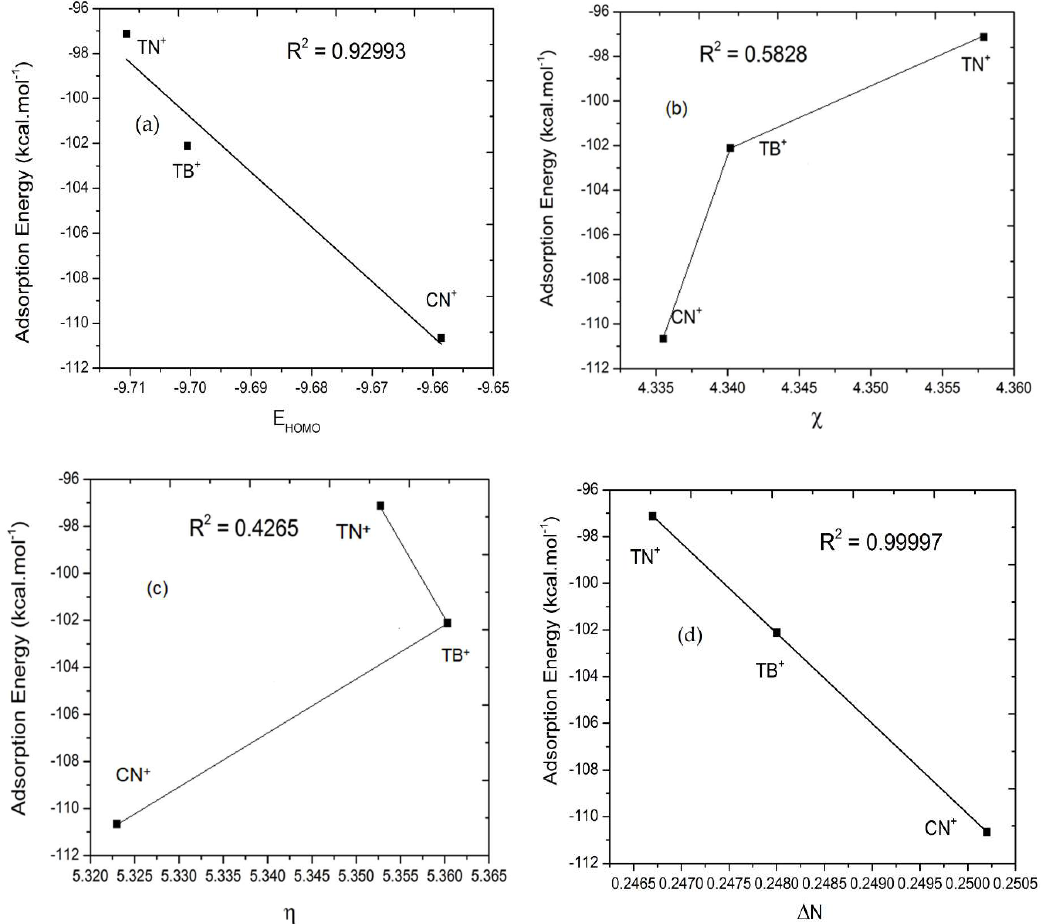
Figure 6. Correlation of the adsorption energy and quantum parameters such as EHOMO, electronegativity, hardness, and electron transfer of protonated inhibitors (caffeine (CN + ), theophylline (TP + ), and theobromine (TB + )) in copper surface. ( a ) The correlation between the adsorption energy and EHOMO, ( b ) the adsorption energy and electronegativity, ( c ) the adsorption energy and hardness, ( d ) the adsorption energy and electron transfer.